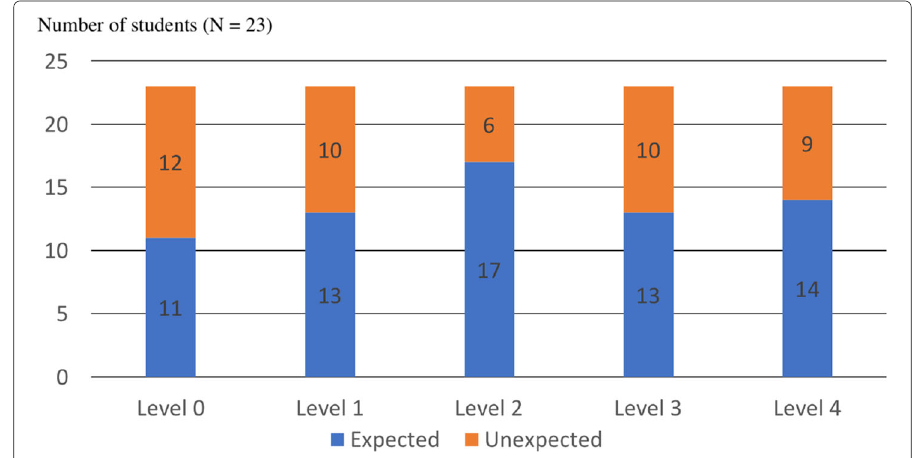
Fig. 10 Result of selecting appropriate feedback for each level